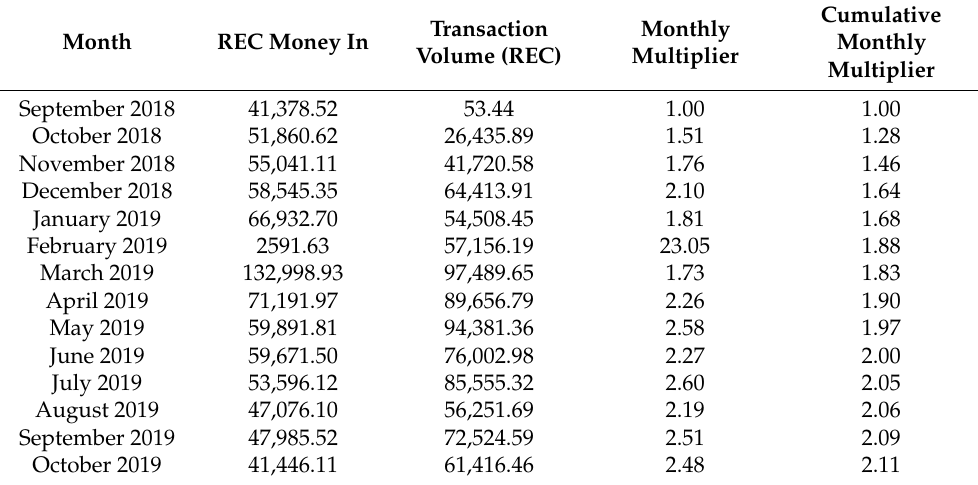
Table 2. Evolution of multiplier of the public spending in the REC System from October 2018 to October